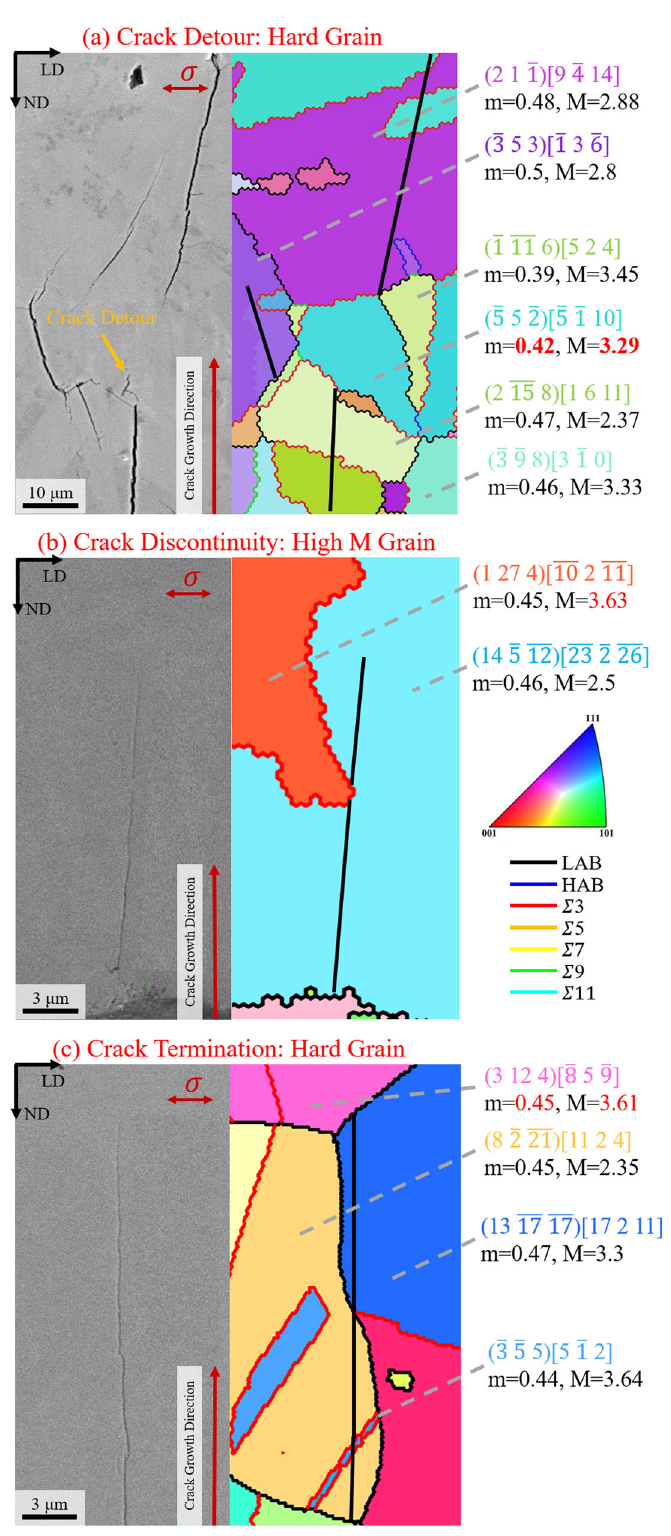
Fig. 3 SEM morphology and EBSD maps of representative crack paths for different cracking behaviors. a Crack detour; b crack discontinuity; c crack termination at GB. All Schmid and Taylor factors are identi fi ed in all grains along the crack paths (images are adapted from ref. 76 Speci fi cally, discontinuities and crack detours are observed in the HAZ on the scanned cross-section surface. In addition, crack The TGSCC crack propagation described in Section 3.1 exhibits terminations occur predominantly when crack tips arrive at grain some notable crack features, which will be highlighted here.